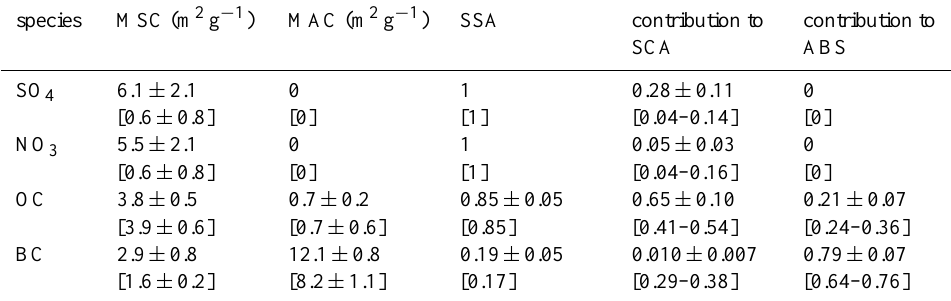
Table 1. Optical properties and contributions to SCA and ABS, all at a wavelength of 550nm. Values from Magi (2009) are listed in brackets for